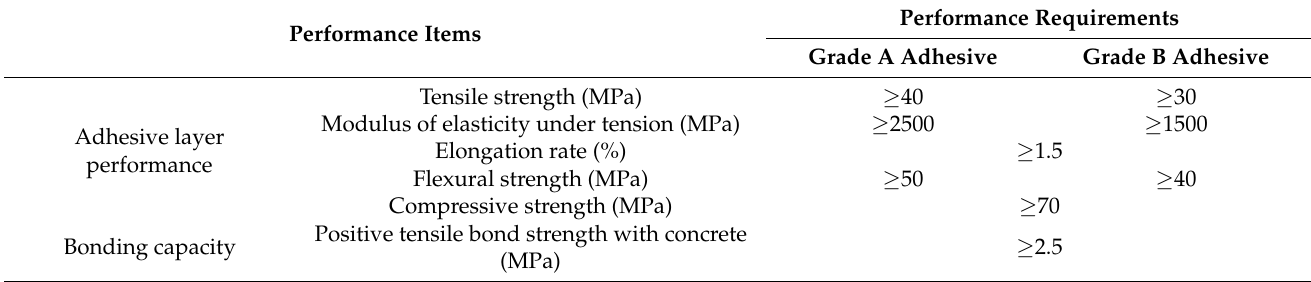
Table 3. Performance parameters of the adhesive